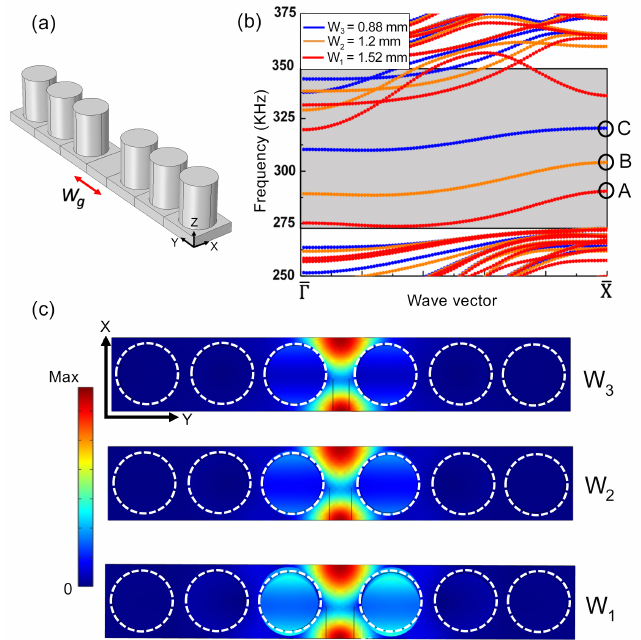
Figure 4. ( a ) Supercell technique to measure three waveguide dispersion curves. W g is the defect distance with W 1 = 1.52 mm, W 2 = 1.22, W 3 = 0.88 mm. ( b ) Dispersion curve for W 1 = 1.52 mm (red), W 2 = 1.22 (orange), W 3 = 0.88 mm (blue). The grey area is the band gap region that ranges from 274 kHz to 350 kHz. ( c ) The out-of plane displacement profile for waveguides, W 1 (bottom), W 2 (middle) and W 3 (top). The dotted-circle indicate the pillar